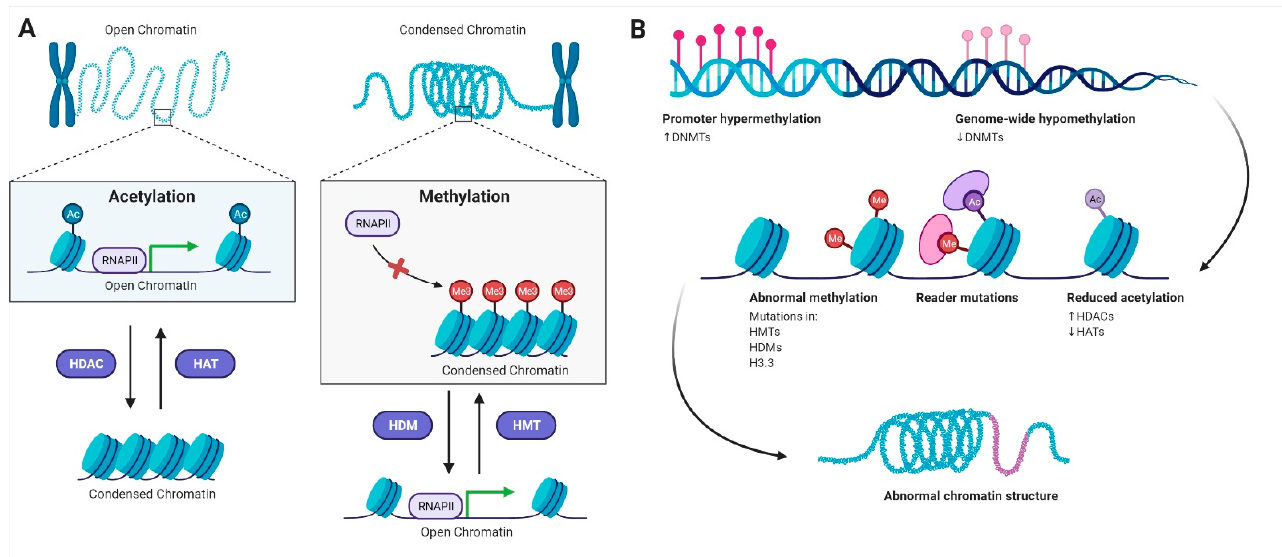
Figure 1. Epigenetic regulatory mechanisms linked to lung cancer. ( A ) Acetylation of histones reduces its positive charge, thereby relaxing the tightly coiled negatively charged DNA wrapped around them. The open chromatin structure enables access to the transcriptional machinery (including RNA polymerase and transcriptional factors), resulting in active gene transcription. Conversely, methylation of histones is generally associated with a condensed chromatin structure, which prevents access to the transcriptional machinery repressing gene transcription. While histone acetyltransferases (HATs) introduce acetyl groups onto lysine residues on histones, histone deacetylases (HDACs) carry out deacetylation of histones. Similarly, histone methyltransferases (HMTs) promote the addition of mono-, di-, or tri-methyl groups at arginine and/or lysine residues on histones, while histone demethylases (HDMs) are responsible for removing these methyl groups. ( B ) Cancer cells display hypermethylation of multiple promoter CpG islands as well as a genome-wide loss of DNA methylation at sporadic CpGs. Methyl-binding proteins are further capable of recruiting HDACs. The overexpression of HMTs and HDACs thus results in reduced chromatin access and silencing of TSG. This abnormal epigenetic activity paves the way to lung cancer development and